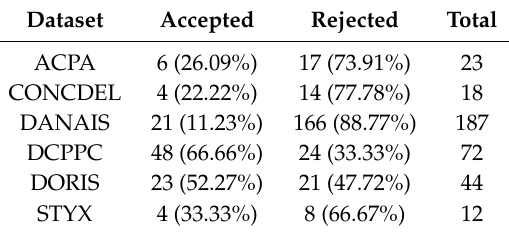
Table 3. Class distributions per claim category.